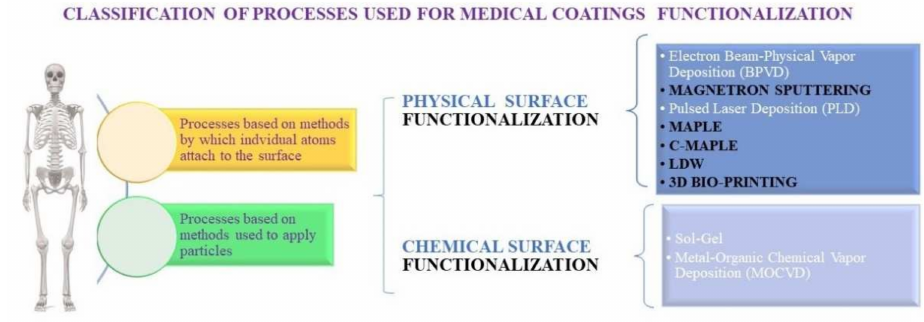
Figure 3. Deposition methods used for surface functionalization at the industrial